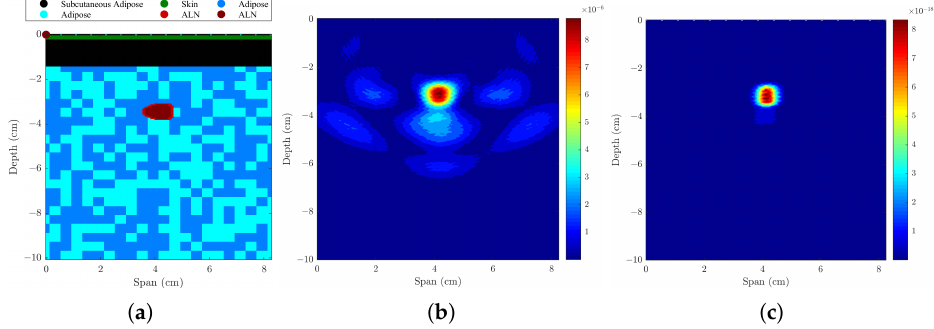
Figure 5. Model and the corresponding backscattered energy results from the implemented MWI system of an axillary region model with an ALN and a subcutaneous adipose layer. The fig- ure shows ( a ) the model and the corresponding backscattered energy results using ( b ) DAS and ( c ) CR-DMAS beamformers after applying Bond’s artifact removal algorithm. The high intensity regions in ( b , c ) indicate the detection of the lymph